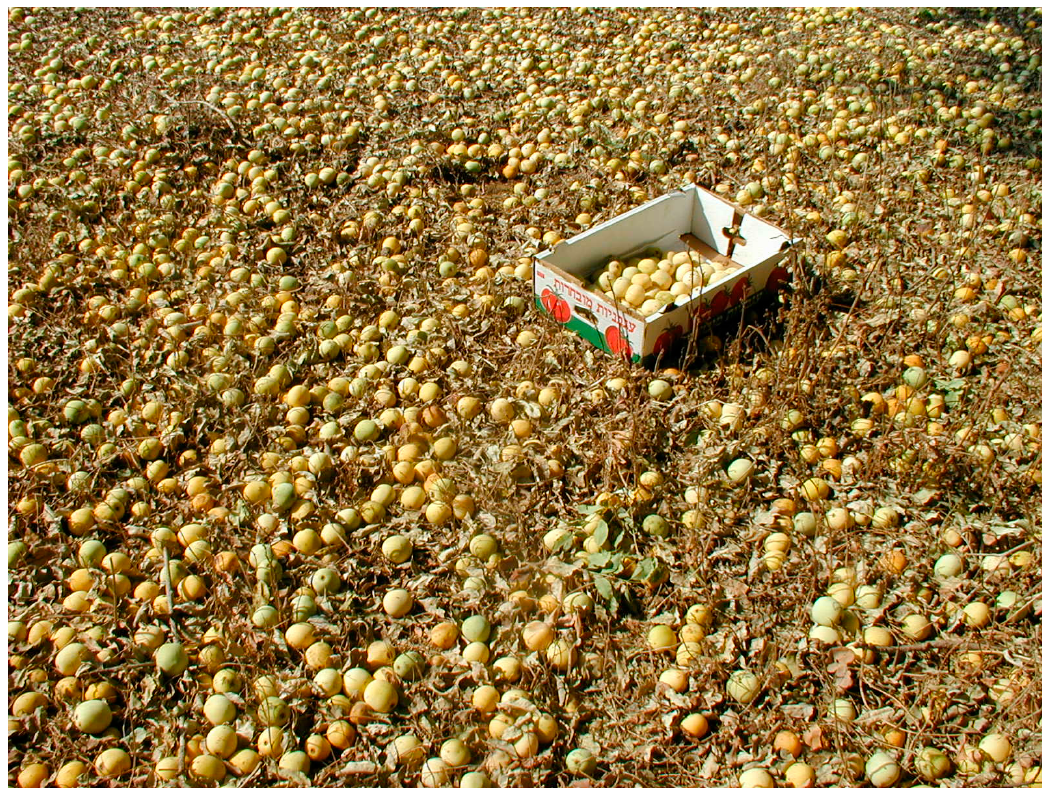
Figure 4. Abscised fruits from the Marula tree. Note green and yellow fruits. Yields are high, at a few hundred Kgs/tree/year.